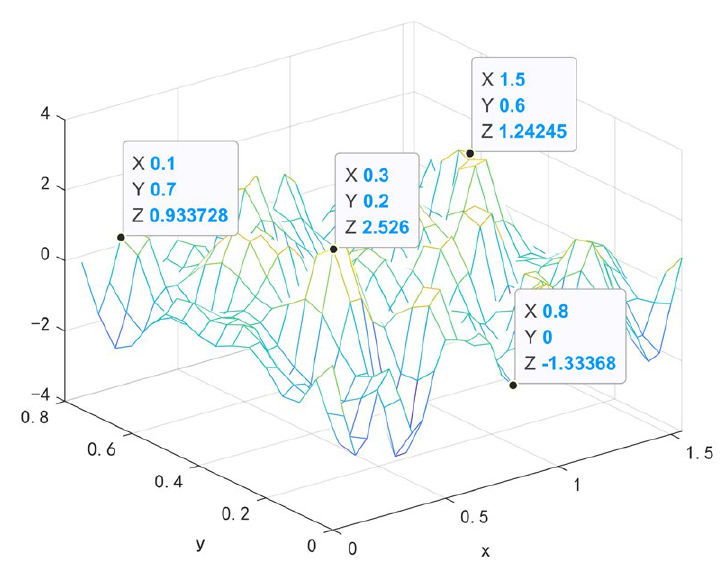
10 of 13 Figure 7. The original angular spectrum. To expand the sequence, the original angular spectrum is zero-padded, and the value of the angular spectrum at a particular location is modified. The angular spectrum after one zero-padding is the angular spectrum after smoothing once, as shown in Figure 8. Figure 8. Generated angular spectrum after one zero-padding. By comparing Figures 7 and 8, it can be concluded that the variation of the angular spectrum of each region conforms to the smoothing theory shown in Figures 2 and 3 in Section 3.2. For reasons of space, the angular spectrum values at each position are not